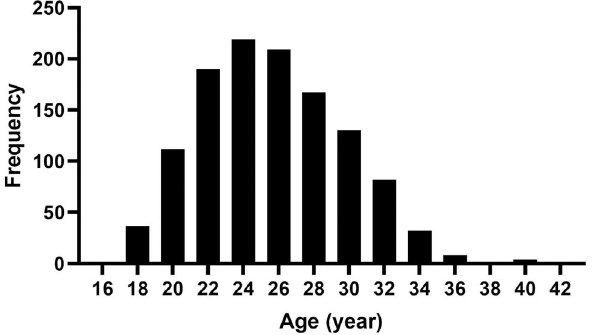
Figure 1 - Age distribution of women's football players in Olympic Games from 1996 to 2016.